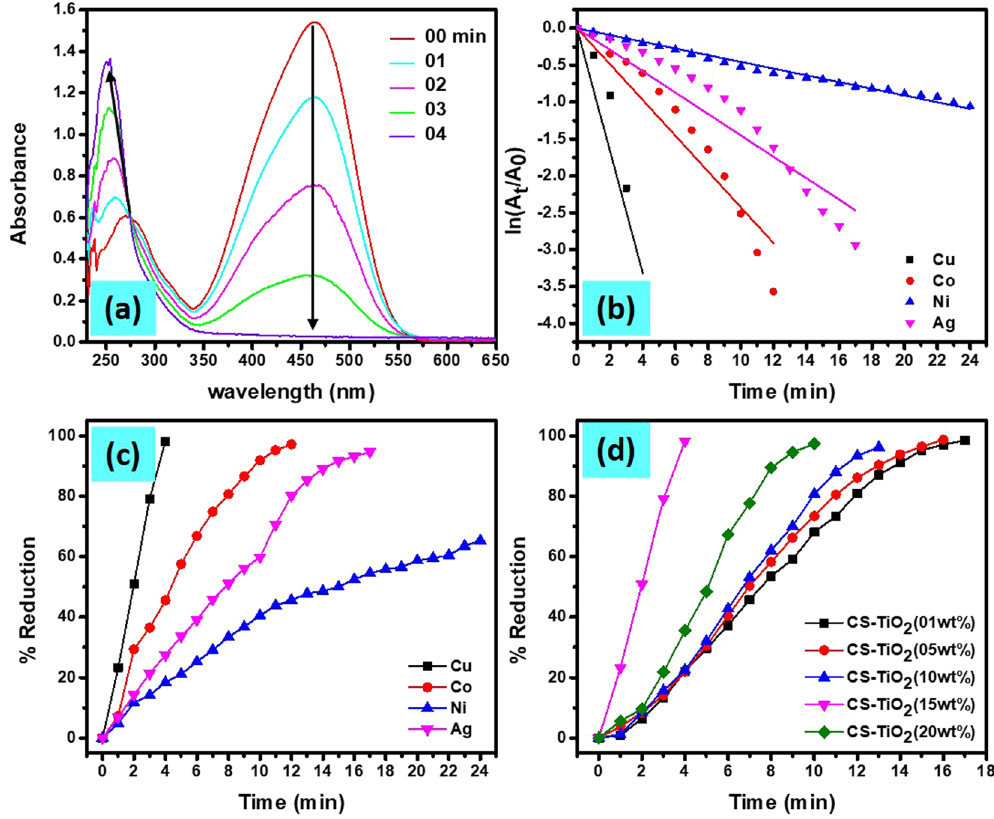
Figure 6. UV-vis spectra of MO dye reduction as a function of time in the presence of Cu/CS-TiO 2 ( a ), Ln (A t / A 0 ) vs time of different MNPs templated on CS-TiO 2 -15 ( b ) Percent reduction of MO with time by different MNPs templated on CS-TiO 2 -15 ( c ) and by Cu-NPs templated on different wt% of TiO 2 in CS-TiO 2 ( d )